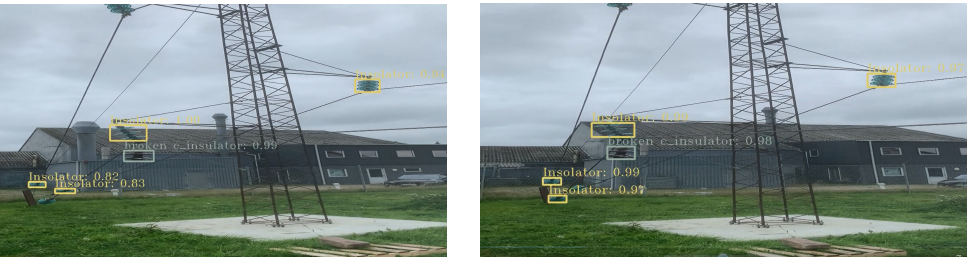
Figure 19. Images from real-time fault detection with an NVIDIA Jetson NX onboard computer. The two images represent different camera angles.